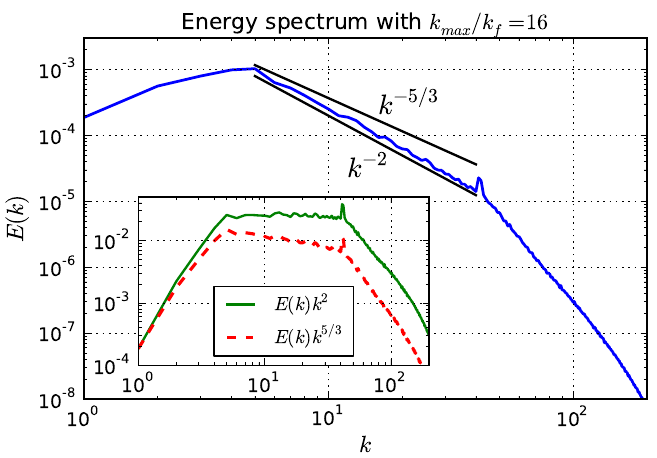
Figure 8 . Energy spectrum E ( k ) (blue, solid) with forcing active at k f = 42, such that k max =k f = 16, where k max = N= 3 and N = 2048. Power laws k (cid:0) 2 and k (cid:0) 5 = 3 (black, solid) are shown for comparison. The inset displays compensated spectra E ( k ) k 2 (green, solid) and E ( k ) k 5 = 3 (red, dashed). The spectrum is well-represented by k (cid:0) 2 , rather than k (cid:0) 5 = 3 , consistent with [51] (albeit for a conformal (cid:13)uid in our case). The best (cid:12)t power-law slope over the range k 2 [5 ; 40] is (cid:0) 2 :